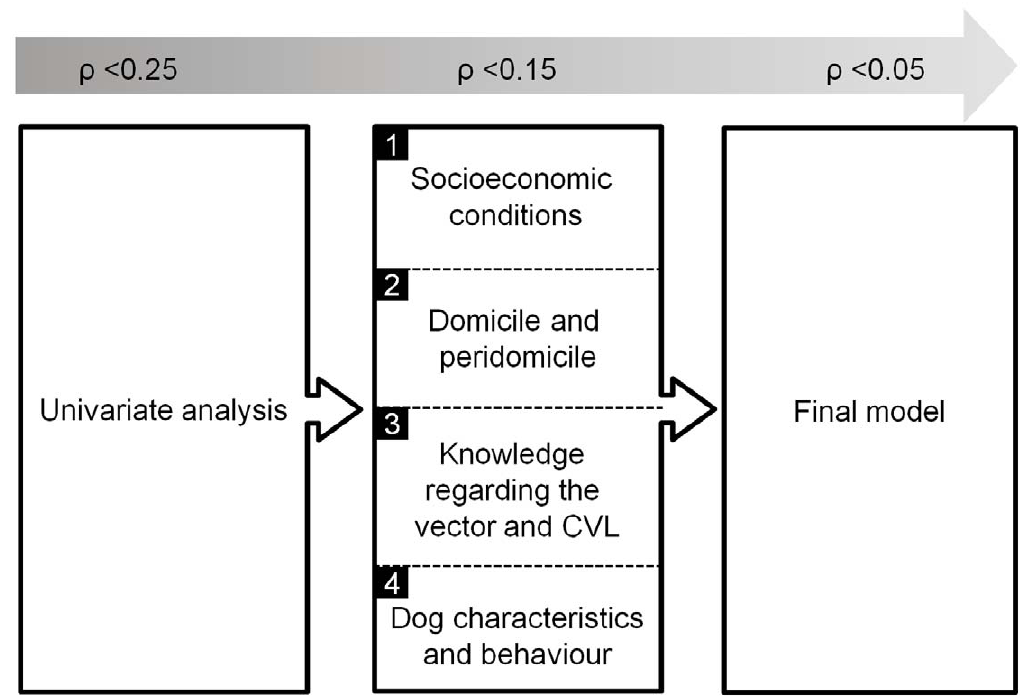
Figure 2. Hierarchical framework of risk factors for Leishmaniainfantum infection in dogs.